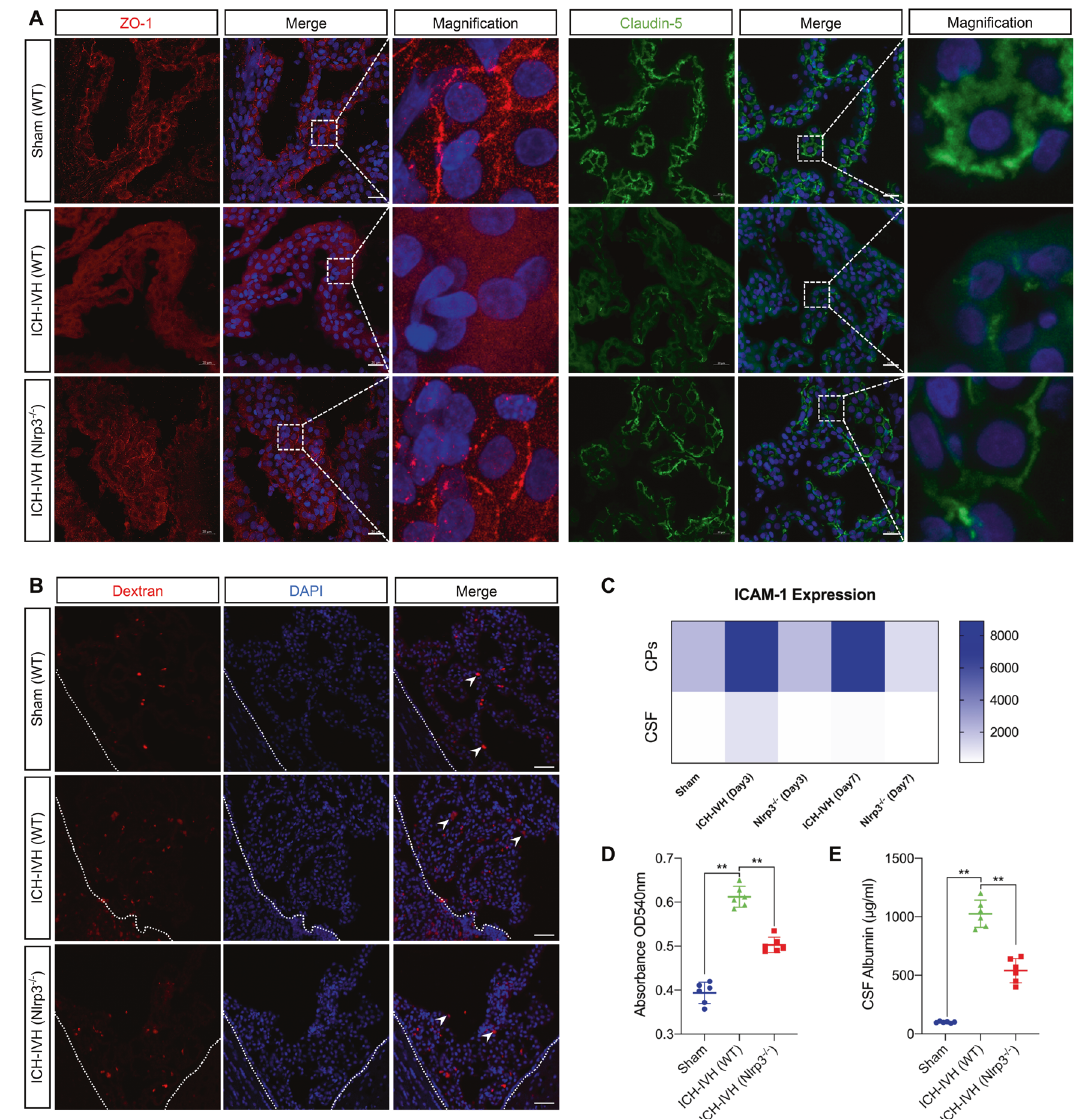
Fig. 3 Assessment of B-CSFB integrity in WT rats and Nlrp3 − / − rats 3 days after ICH-IVH. A Representative images of immuno fl uorescence staining for ZO-1 and claudin-5 in the choroid plexus of different groups. Scale bar = 20 μ m. B Pictures of B-CSFB leakage assessed by dextran. Scale bar = 50 μ m. C Heatmap of ICAM-1 expression in the choroid plexus and CSF ( n = 3, one-way ANOVA). D Results of the absorbance assay of CAFs in different groups after dextran injection ( n = 3, one-way ANOVA). E Statistical results of CSF albumin content in different groups ( n = 6, one-way ANOVA). The results are expressed as the mean ± SD, ** P <